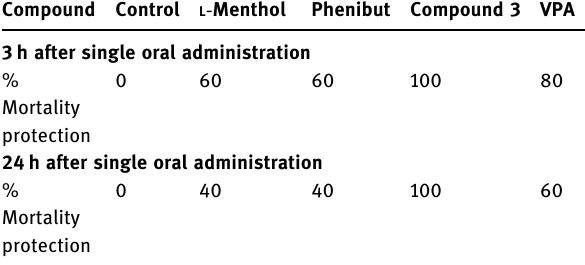
Table 1: Anticonvulsant e ff ect of ester 3 , L - menthol, phenibut, and VPA against MES - induced seizures in mice ( n = 10 animals in each group ) Compound Control L -